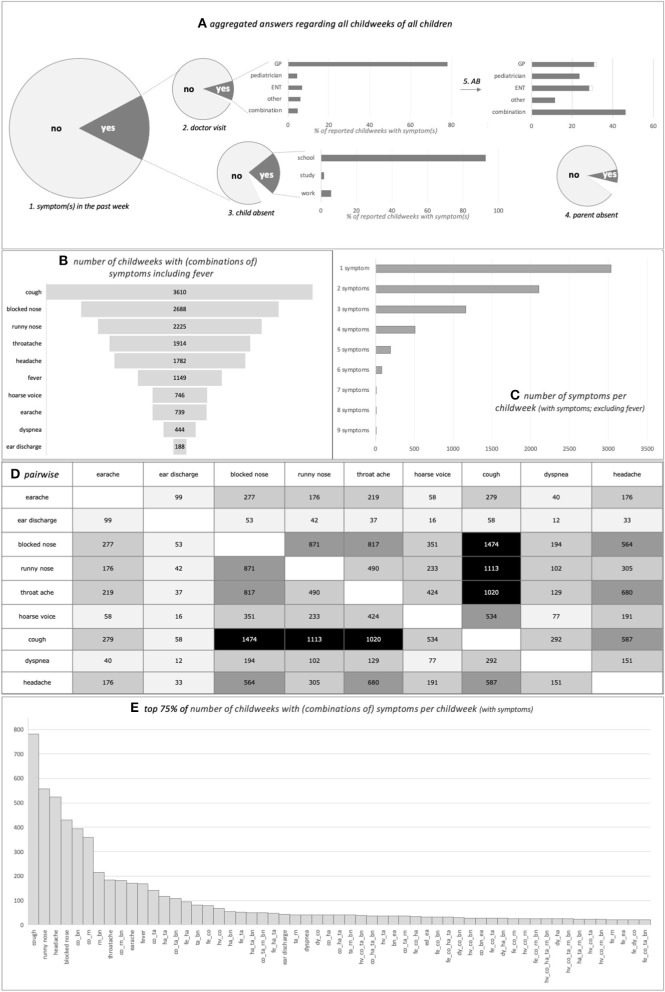
The various parent-reported (combinations of) symptoms in the cohort in all childweeks taken together. (A) From left to right: 1, “any symptom(s) present in the past week (yes/no)” is shown. When the answer was “yes:” 2, “did the child visit a doctor” and if so “was this a GP/ENT/other/combination (percentages in bar chart);” 3, “was the child absent from school/study/work (percentages in bar chart);” and 4, “did the parent have to stay home from work” is shown. The top right bar chart shows the percentage of children who received an antibiotic prescription (5). The size of the pie charts is proportional to the relevant number of childweeks per item. Symptoms “yes,” n = 8,425 childweeks (15.2%), leading to child's absenteeism in 25.4%, parental sick leave in 8.1%, doctor visit in 11.8%, and antibiotic prescription in 26.3%. White area in graphs = unknown (n = 587 childweeks child's absenteeism unknown, n = 558 childweeks parental sick leave unknown, n = 118 childweeks doctor visit unknown, n = 242 childweeks antibiotics prescribed unknown; antibiotics prescribed, but doctor unknown is not shown in antibiotics graph, n = 4 childweeks). AB, antibiotics; combination, more than one doctor was visited; ENT, ear–nose–throat specialist; GP, general practitioner; other, another doctor than GP/pediatrician/ENT was visited. (B) Number of childweeks where the symptom was reported (including fever). (C) Number of childweeks where one to nine symptoms were reported in the same week (excluding fever). (D) Number of childweeks where the symptom on the one axis was reported concurrently with the symptom on the other axis (either simultaneously with or not simultaneously with other symptoms); a larger number is reflected in darker shading of the cell (excluding fever). (E) Top 75% of number of childweeks with (combinations of) symptoms per childweek with symptoms (including fever). X-axis combination(s) of symptom(s): bn, blocked nose; co, cough; dy, dyspnea; ea, earache; ed, ear discharge; fe, fever; ha, headache; hv, hoarse voice; ta, throat ache; rn, runny nose.